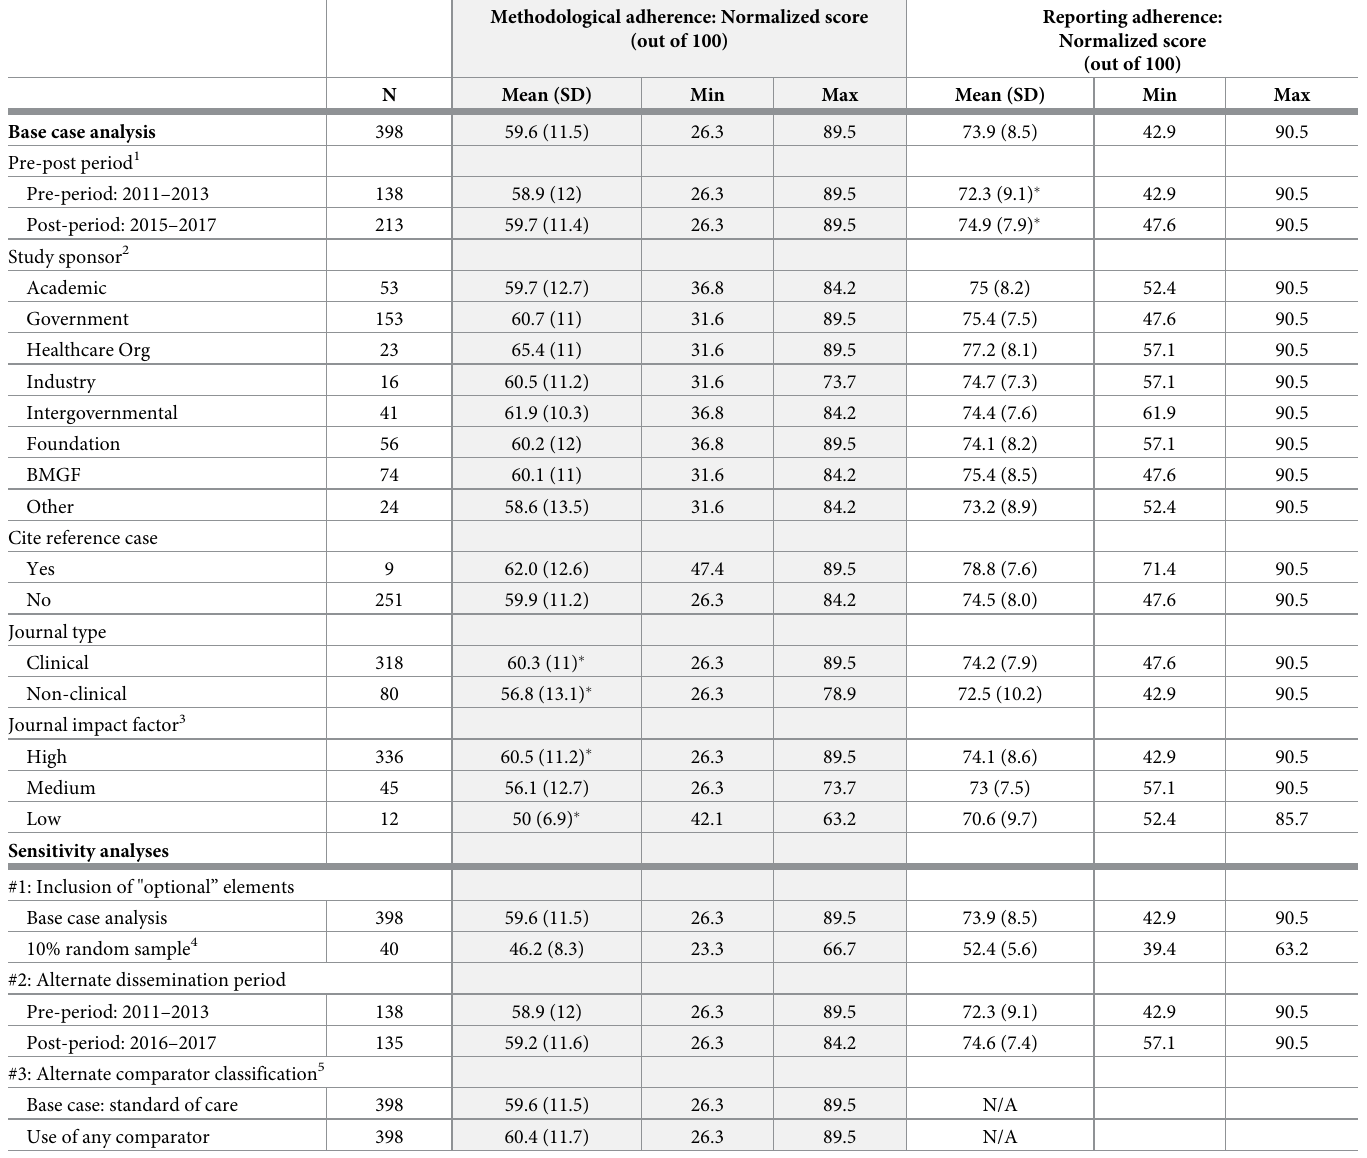
Table 3. iDSI reference case adherence scores by year, sponsor, and journal